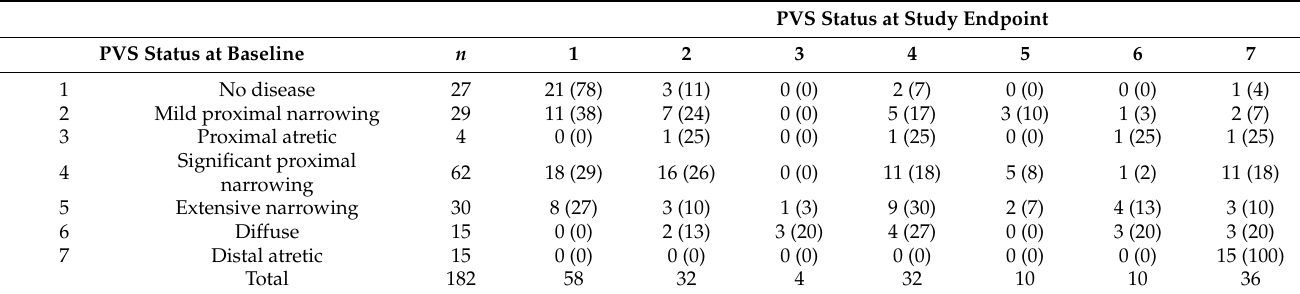
Table 3. Change in disease status, baseline to study endpoint.